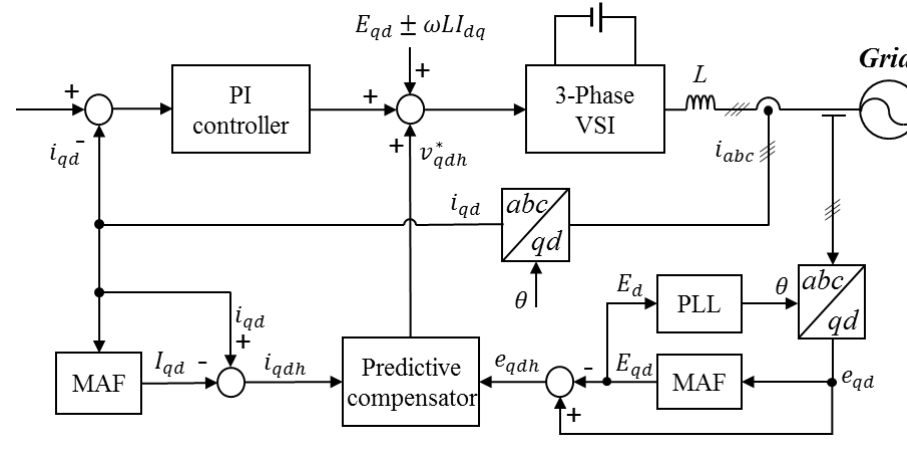
Figure 2. Block diagram of the proposed control scheme.